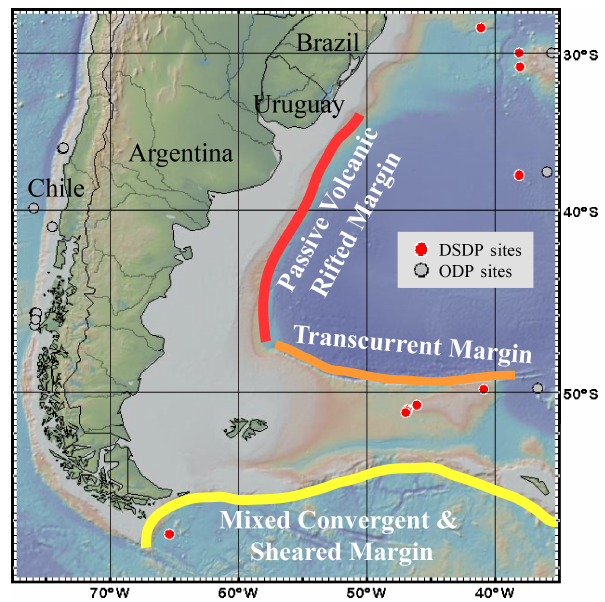
Figure 1. The character of the Argentine Continental Margin. Red: passive volcanic rifted margin; orange: transcurrent margin; yel- low: mixed convergent and sheared margin. The passive volcanic rifted margin is termed the APVCM. Red dots indicate DSDP (Deep Sea Drilling Project) sites, gray dots indicate ODP (Ocean Drilling Program) sites. The figure was constructed in GeoMapApp (http: //www.geomapapp.org) using the Global Multi-Resolution Topog- raphy (GMRT) synthesis (Ryan et al.,